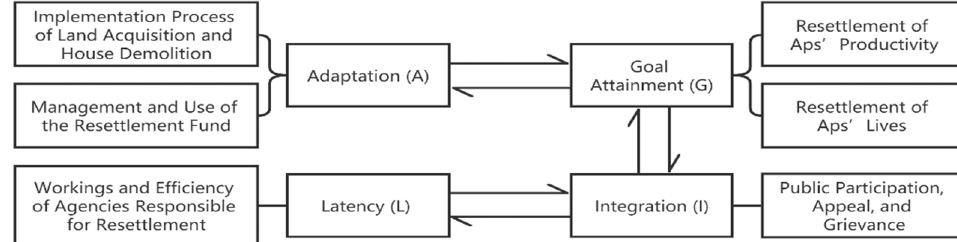
Figure 2. The Functional Distribution of the Present Monitoring and Evaluation of Resettlement Based on the AGIL Scheme.